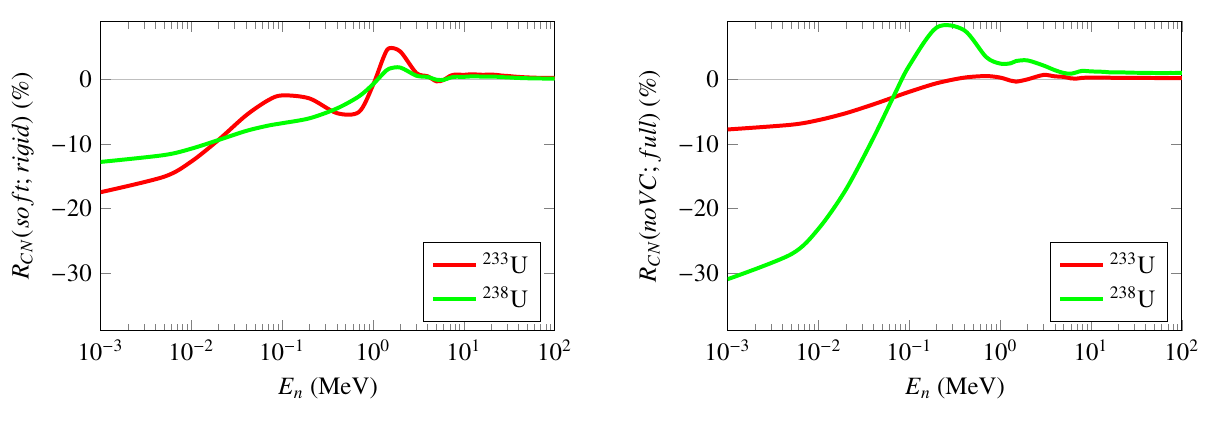
Figure 6. Change of CN formation cross section if the volume conservation is neglected within current model with full cou-